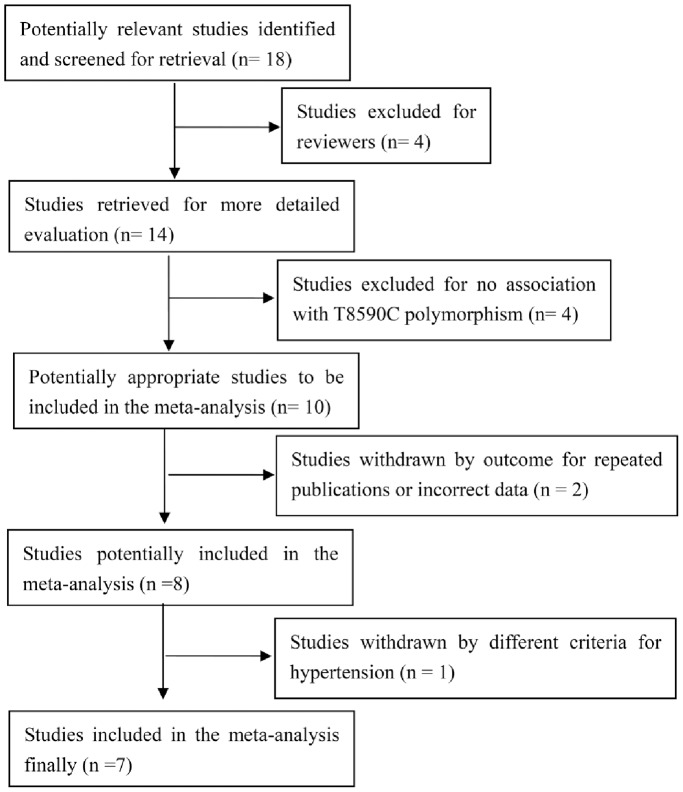
Flow diagram of article selection process for meta-analysis of the CYP4A11 T8590C polymorphism and hypertension.